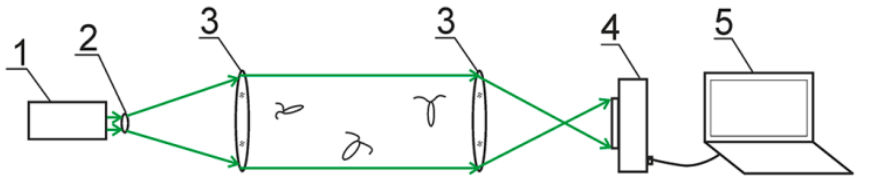
Figure 1. In-line scheme of digital hologram recording: 1 — laser diode, 2 — beam expander, 3 — lens, 4 — CCD/CMOS camera, 5 — computer.